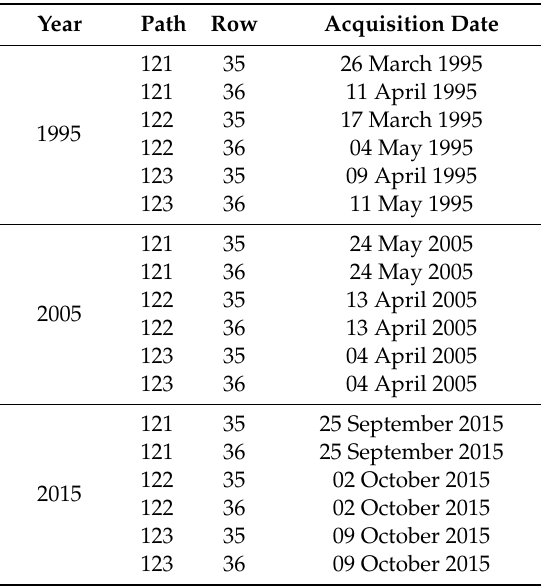
Table 1. List of Landsat